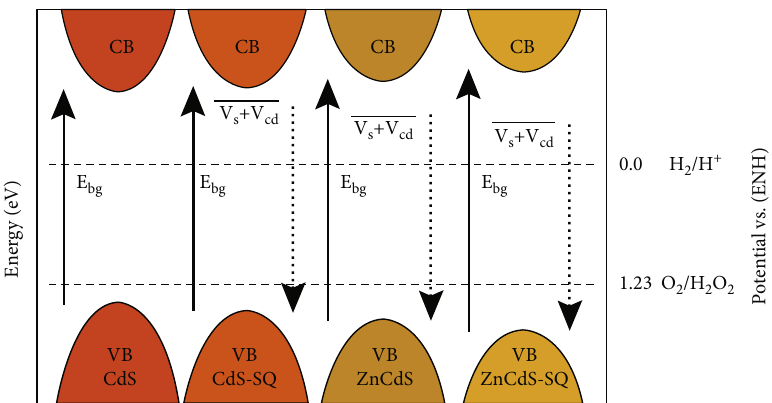
Figure 10: Charge carriers ’ separation schematic diagram for the CdS, CdS-SQ, Zn